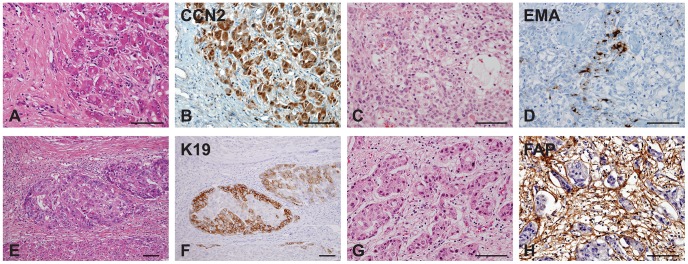
Connective tissue growth factor (CCN2), epithelial membrane antigen (EMA), fibroblast activation protein (FAP), and keratin 19 (K19) expression in hepatocellular carcinomas (HCCs) of cohort 1.A) Small nests of tumor cells are surrounded by fibrous stroma. B) Immunohistochemistry for CCN2 exhibits diffuse cytoplasmic expression in tumor epithelial cells of HCC. C–D) Immunohistochemistry for EMA reveals patchy or focal expression pattern in tumor epithelial cells of HCC. E–F) K19 is focally positive in the periphery of tumor nests. (G–H) FAP is expressed in the cytoplasm of cancer-associated fibroblasts of tumor stroma. (Scale bars represent 100 µm.)